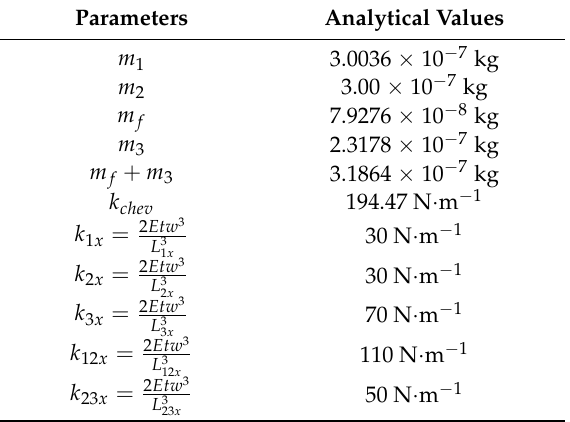
Table 1. The summary of the optimized design parameters for drive mode